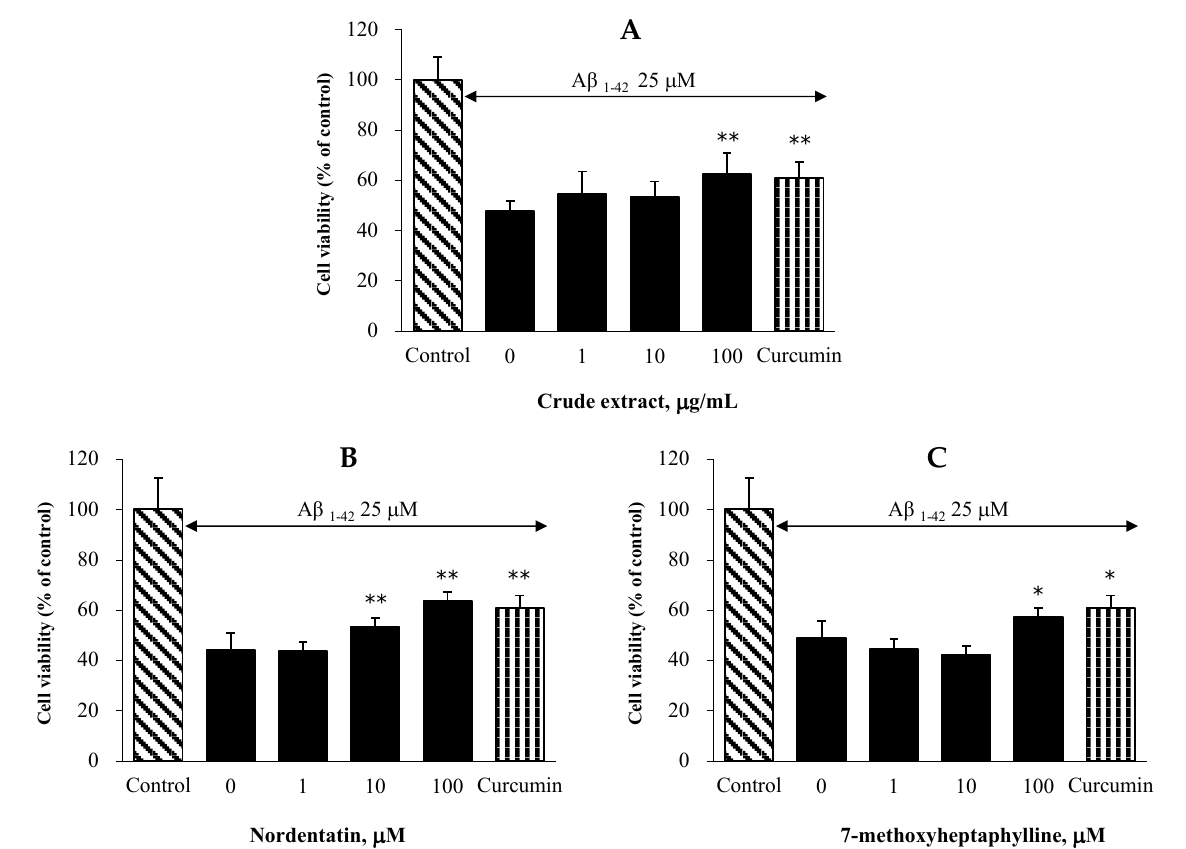
Figure 3. Effects of the CH extract at the concentrations of 0, 1, 10, and 100 µ g/mL ( A ), and its constituents nordentatin ( B ) and 7-methoxyhepthaphylline ( C ) at the concentrations of 0, 1, 10, and 100 µ M on A β 1-42-induced neuronal cell death in C6 cells. The values are reported as means ± SDs (n = 5). One-way ANOVA followed by the Turkey test, * p < 0.05 and ** p < 0.01 compared with the A β 1-42-treated control group.